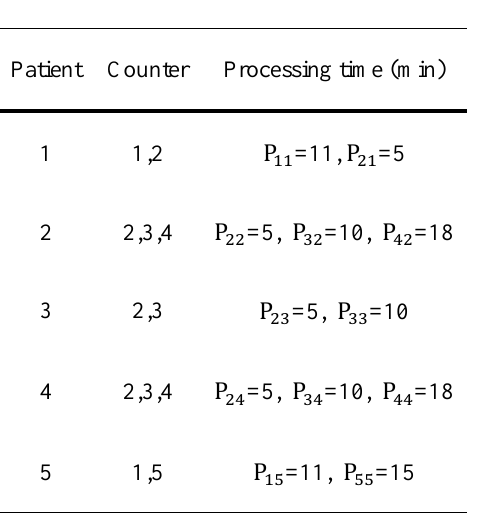
Table 1. Schedule